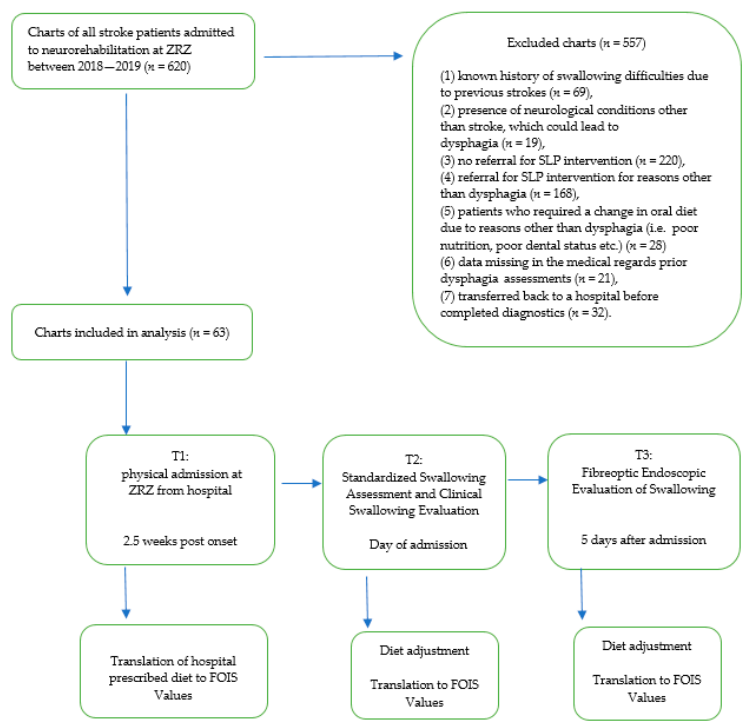
Figure 1. Chart review process. Abbreviations: ZRZ, Zurcher RehaZentren; SLP, speech and language pathologist; FOIS, Functional Oral Intake Scale.